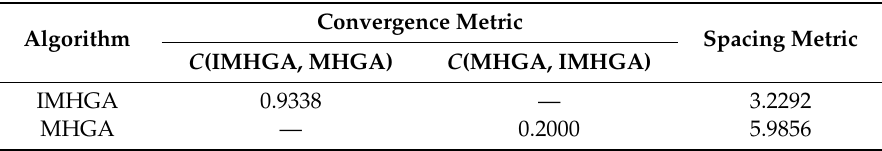
Table 7. Result of the evaluation metrics of the IMHAG and